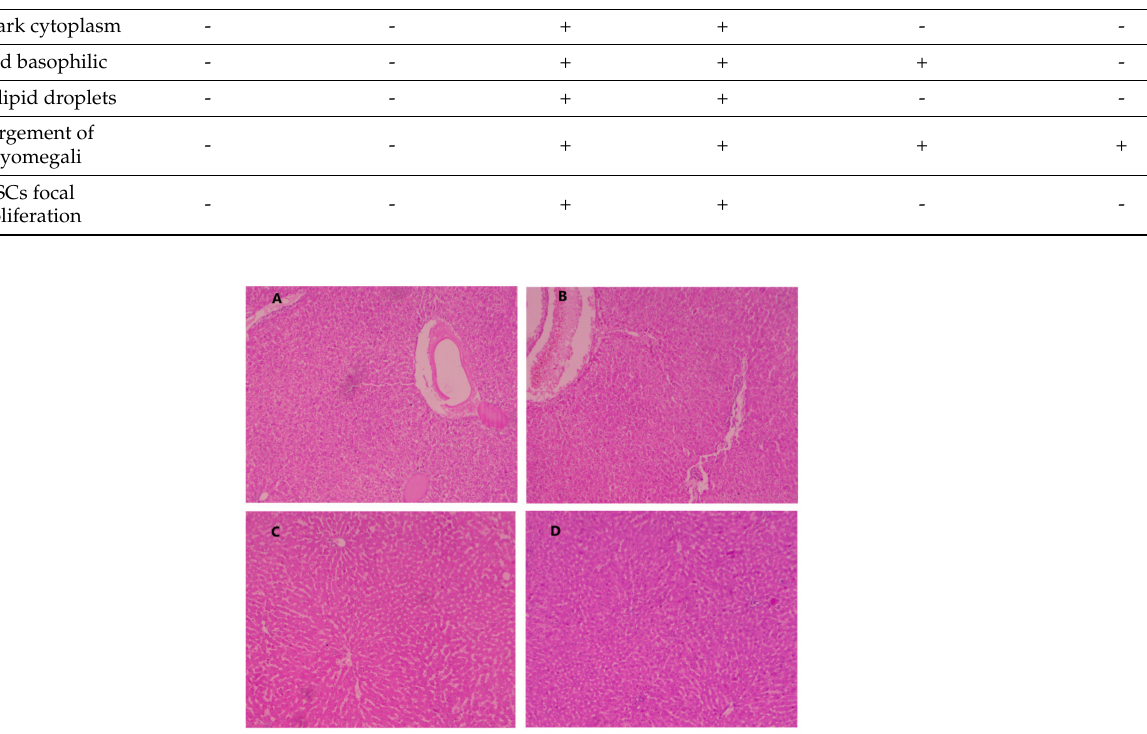
Figure 2. Effect of debelalactone on normal control and DENA induced tumorgenesis rats liver histopathol- ogy. ( A ): DEN Control: DENA control group rats showed the macrodroplet of fats, inflammatory